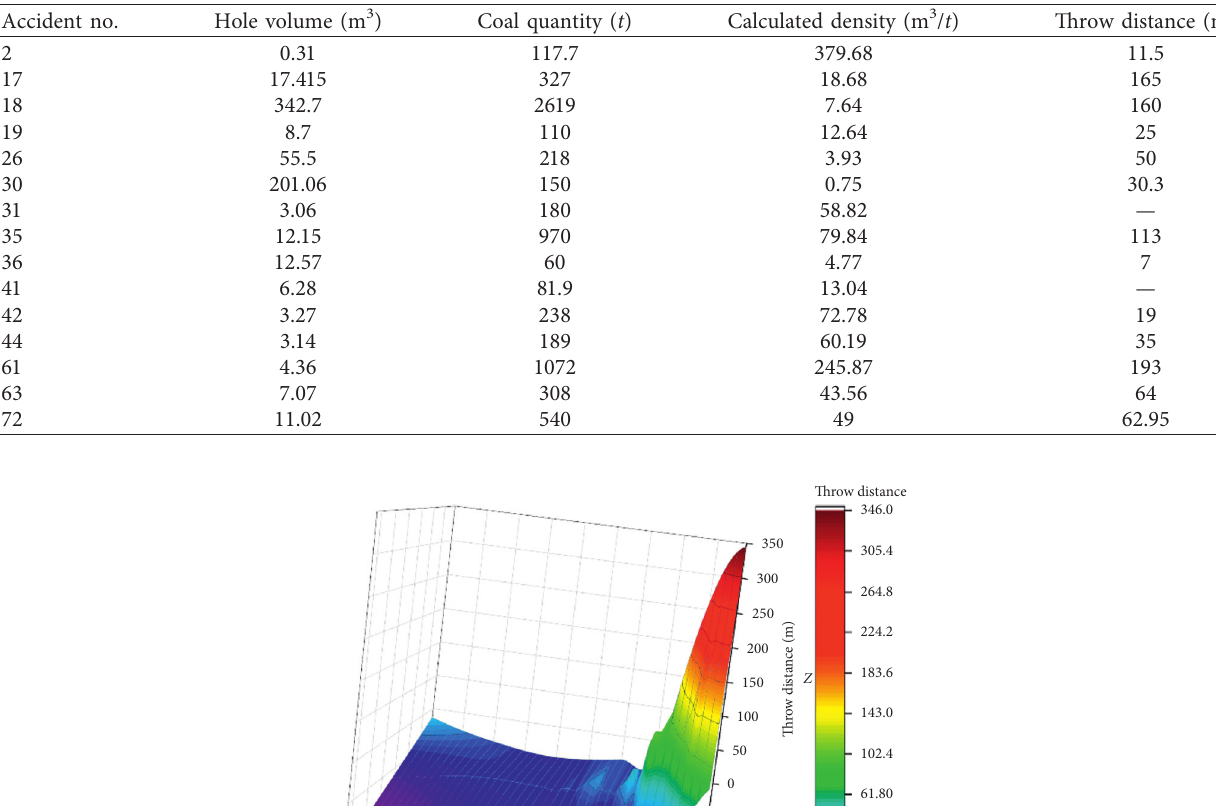
Table 5: Parameters for 15 CGOH.